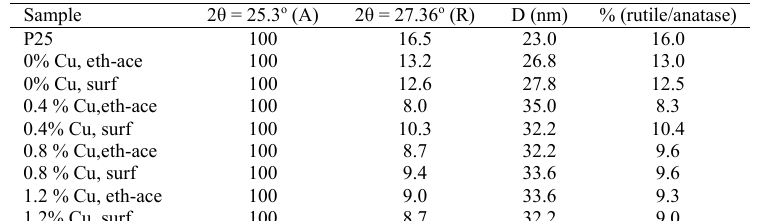
Table 1. TiO 2 crystal dimension and relative intensity of some characteristic peaks of P25 and the prepared samples, (Anatase (A), Rutile (R)).